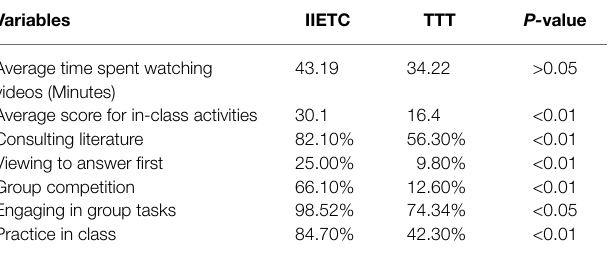
TABLE 4 | The achievement analysis of biological students with two culture conditions.